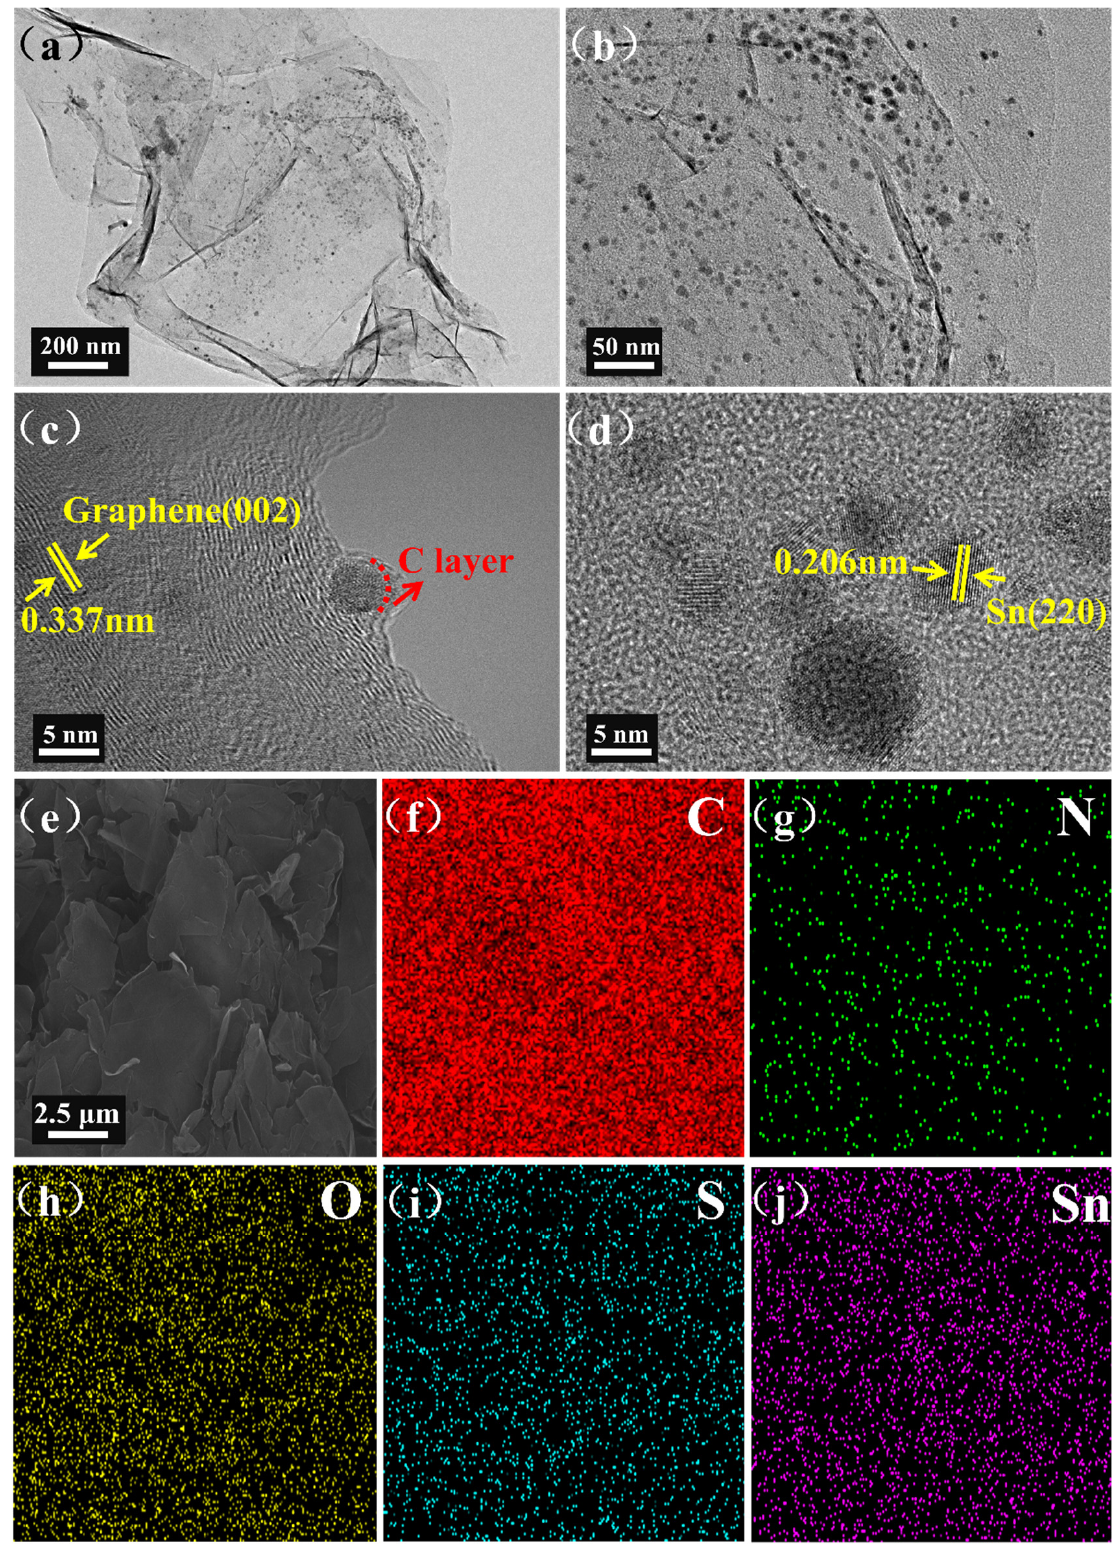
Figure 3. TEM and HRTEM images ( a – d ) of the C@Sn/NSG r − 7.5 sample, SEM image of the C@Sn/ NSG r − 7.5 sample ( e ) and corresponding elemental mapping images of C ( f ), N ( g ), O ( h ), S ( i ) and Sn ( j ) .